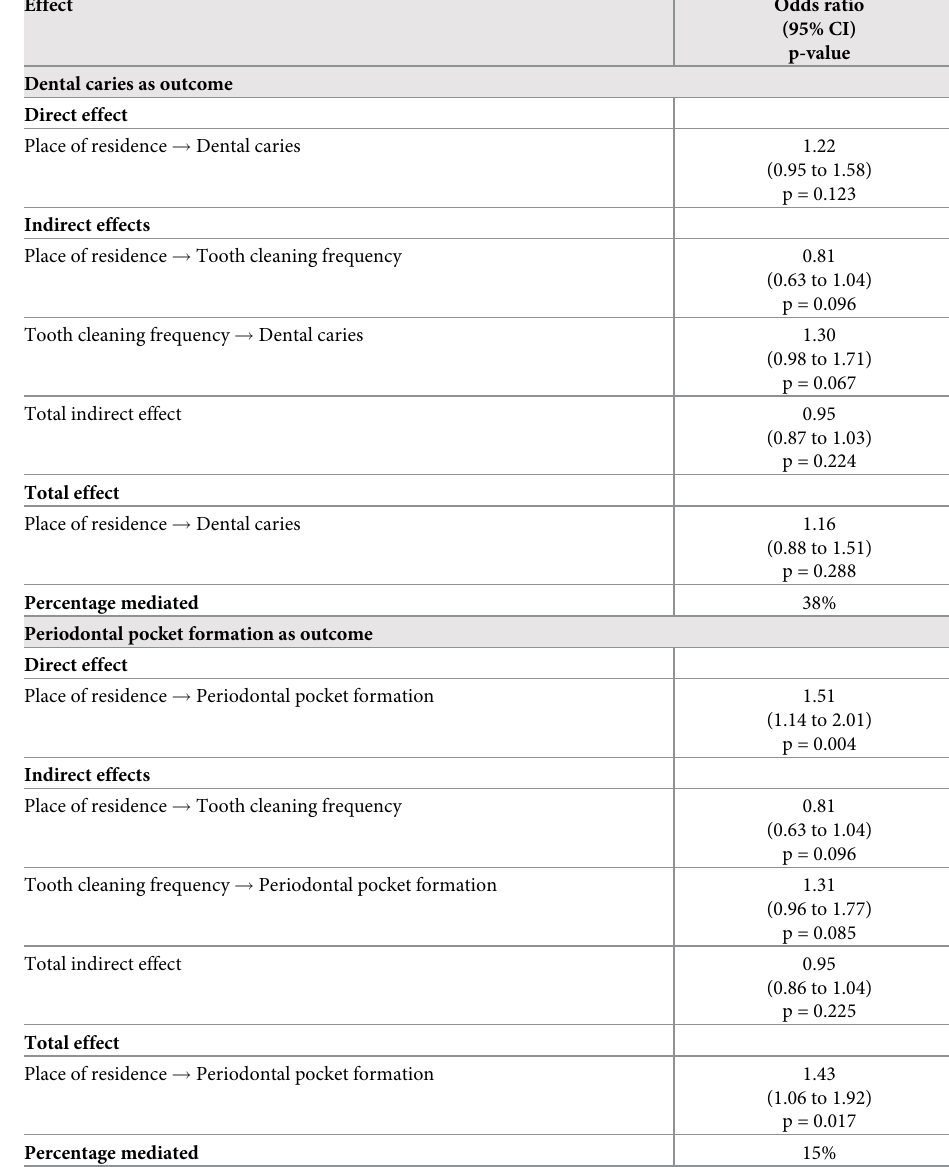
Table 3. Generalized structural equation modeling to explore potential mediator frequency of tooth cleaning on the relationship between place of residence and oral health